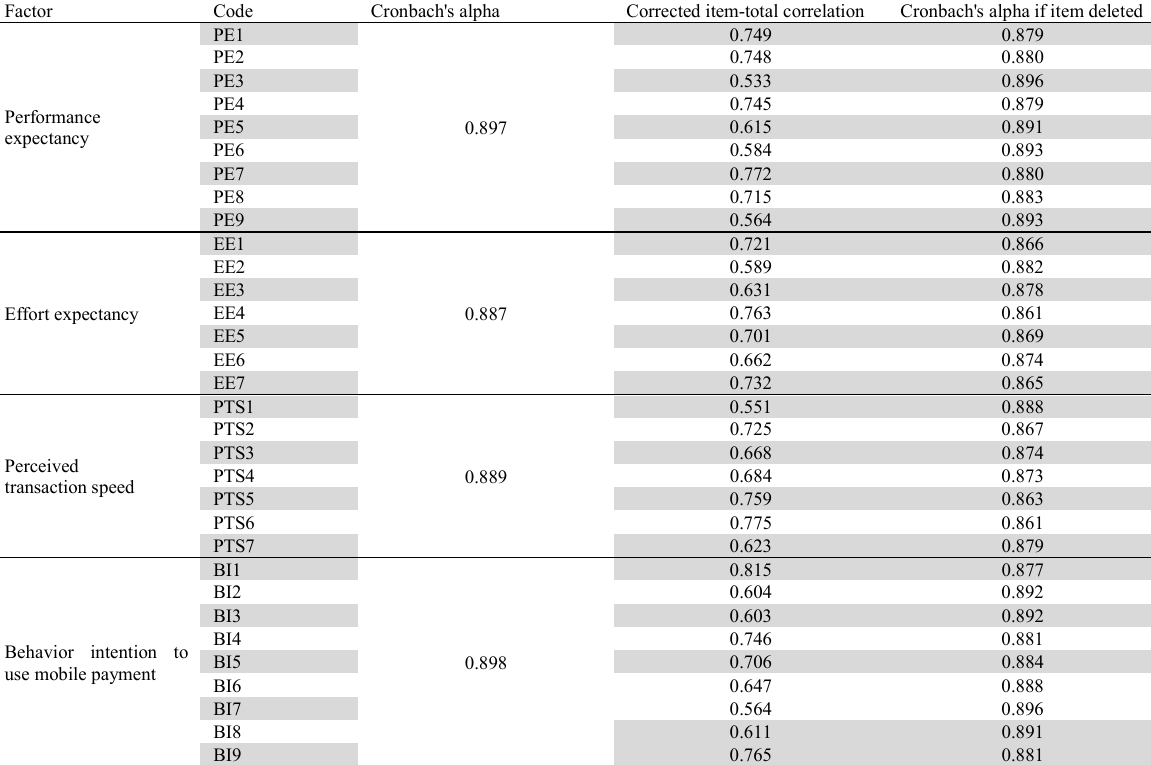
Reliability test